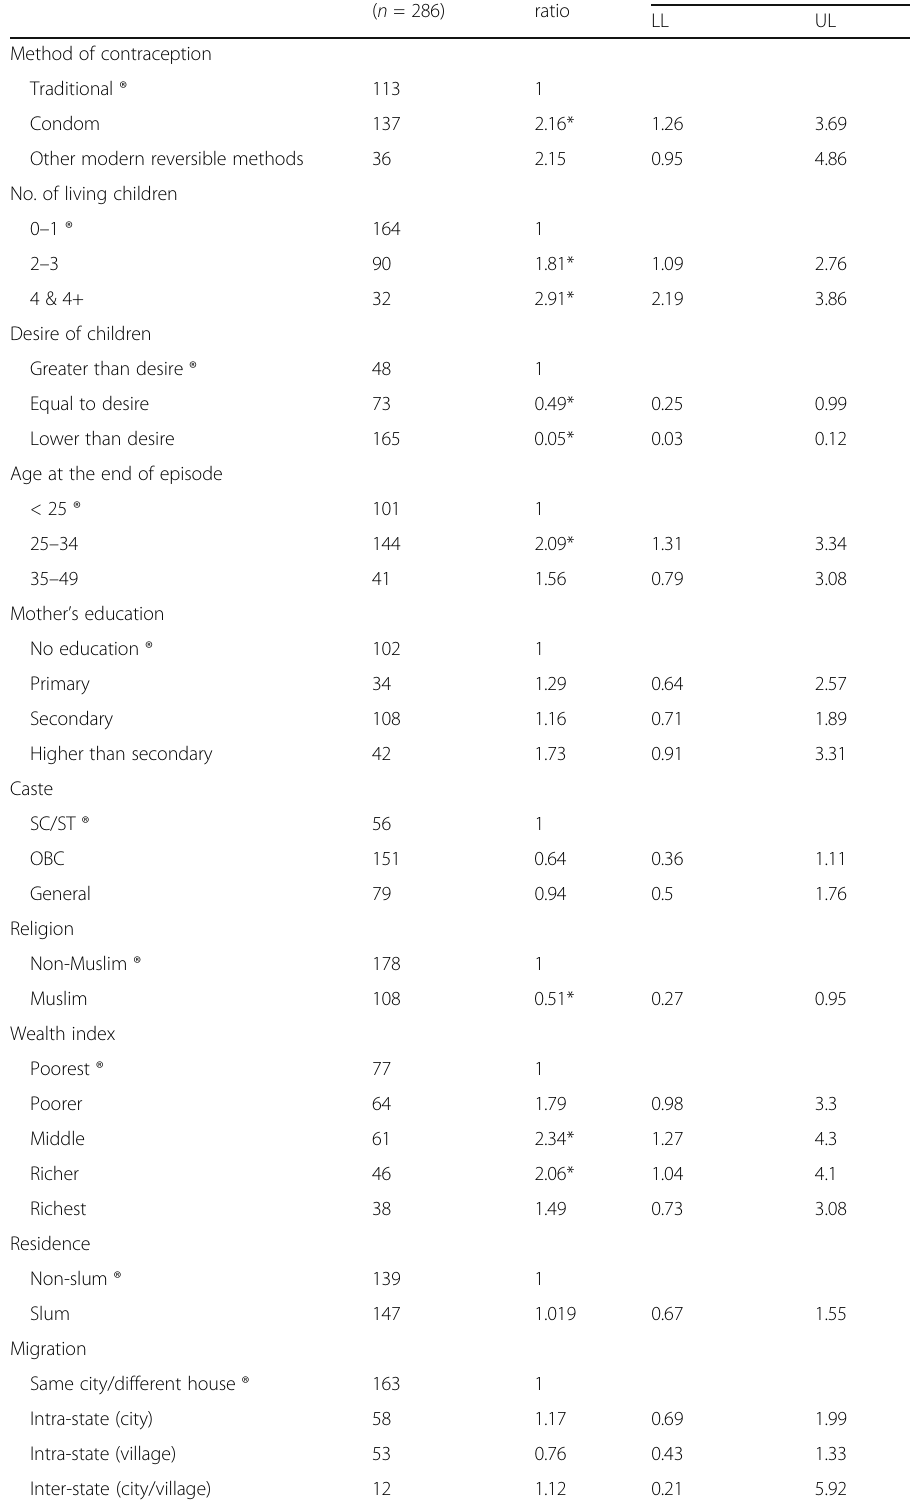
Table 6 Logistic regression results of induced abortion by socioeconomic and demographic characteristics of